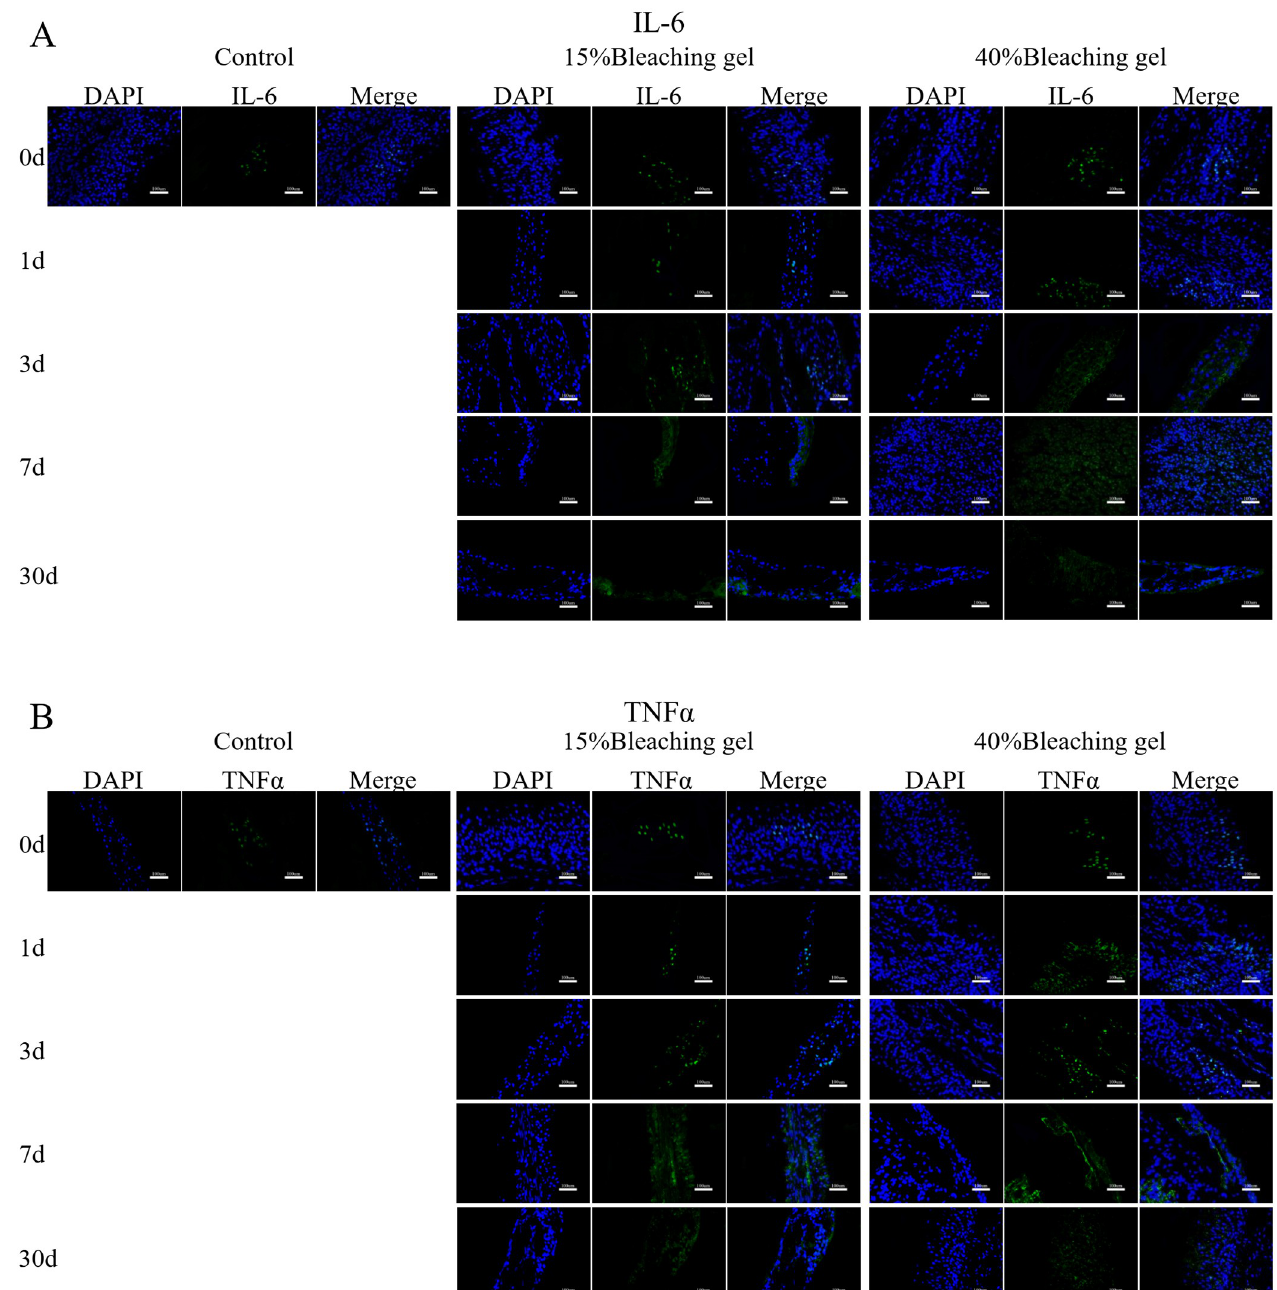
Fig 6. Immunofluorescence staining of IL-6 and TNF α in the rat incisor after gel bleaching. The rat incisors were bleached using the 15% or 40% gel for 90 and 30 min, respectively. After 0, 1, 3, 7, and 30 days, immunofluorescence staining was used to detect IL-6 and TNF α levels in the incisor pulp. The nuclei shown in blue were stained using DAPI. Bar = 100 μ m. IL-6, interleukin 6; TNF α , tumor necrosis